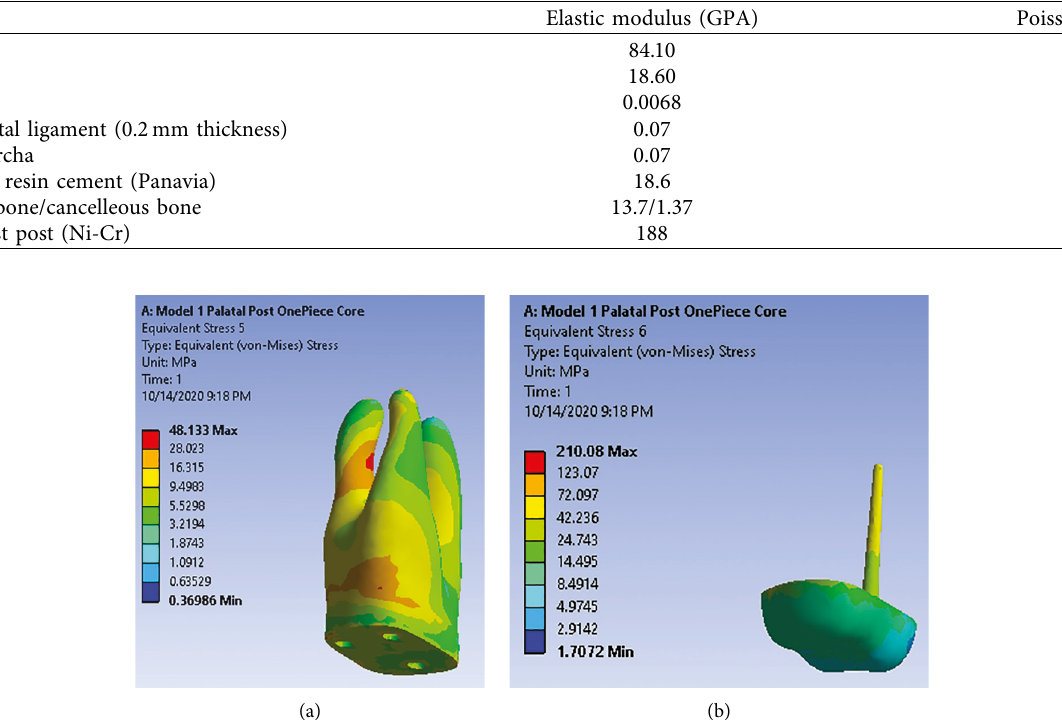
Figure 2: (a) Stress distribution pattern in dentin under 480 (N) along model 1. (b) Stress distribution pattern in post-core under 480 (N) along model 1.